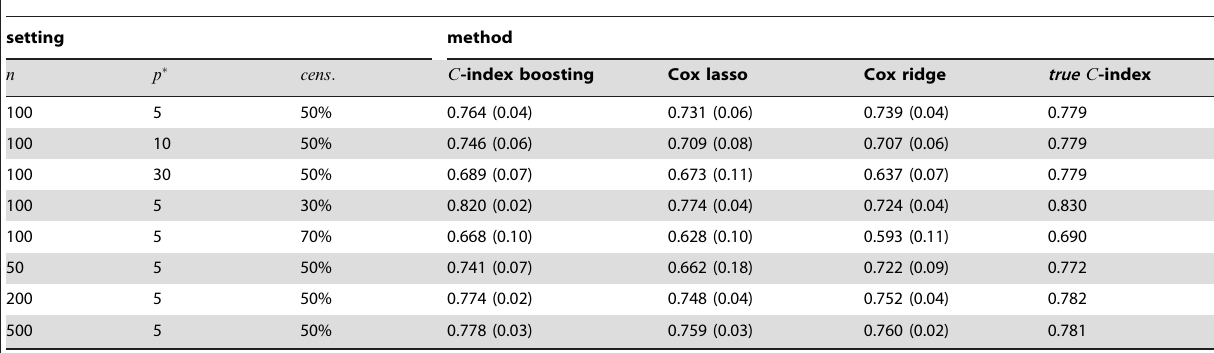
Table 1. Results of the simulation